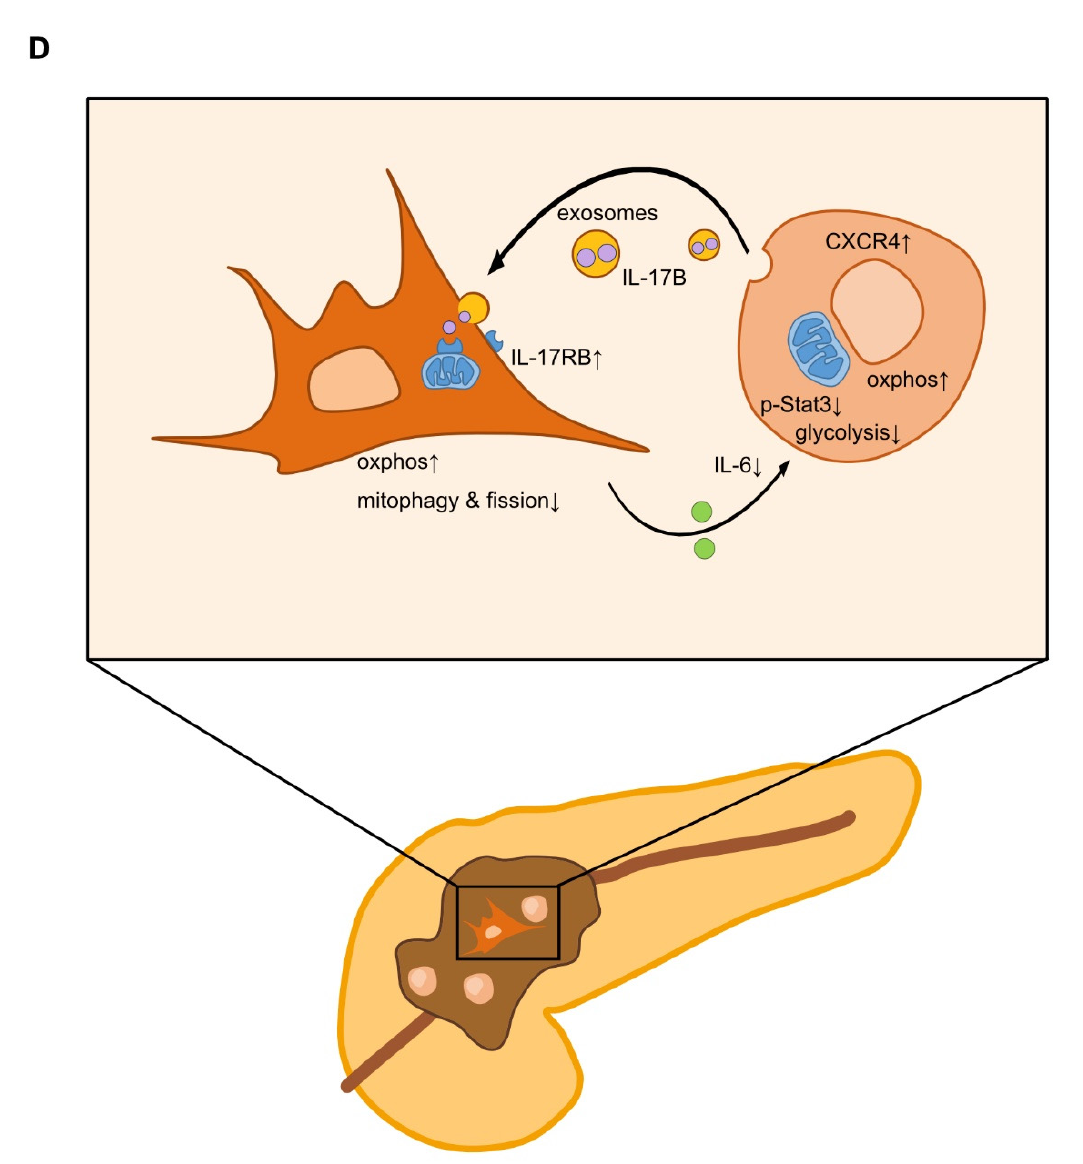
Figure 6. Subcellular location of IL-17RB in PDAC tumor and PSC cells ( A ) IL-17RB is localized on the mitochondria of PSCs (RLT-PSC cell line, human primary PSC preparations) and L3.6pl tumor cells. Representative confocal